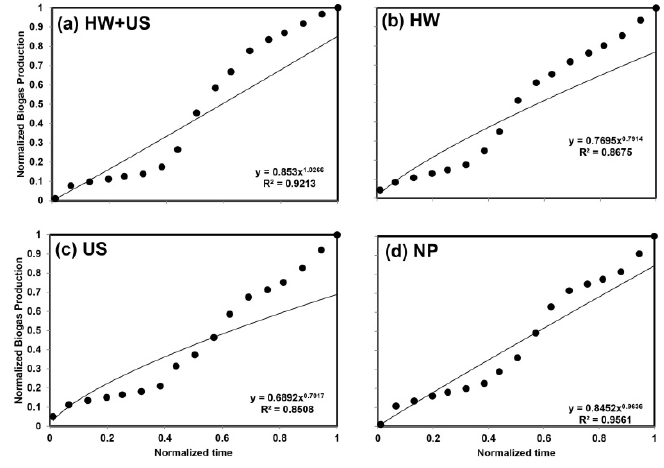
Figure 4. Normalized biogas production rate.